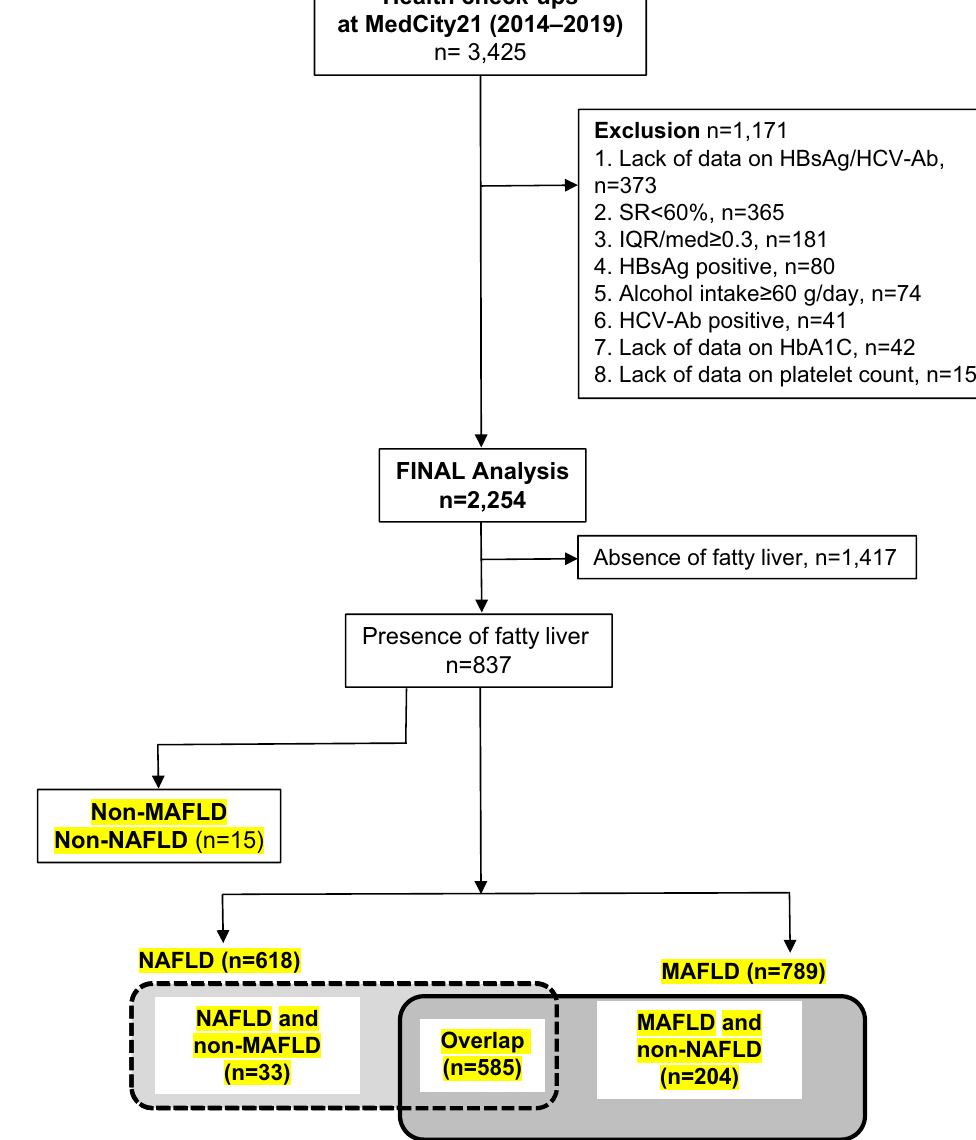
Figure 1. Flow chart of the study participants. HbA1C: glycated hemoglobin; HBV: hepatitis B virus; HBsAg/ HCV-Ab: hepatitis B surface antigen/anti-hepatitis C antibody; HCV: hepatitis C virus; IQR/med: interquartile range/median; NAFLD: nonalcoholic fatty liver disease; MAFLD: metabolic dysfunction-associated fatty liver